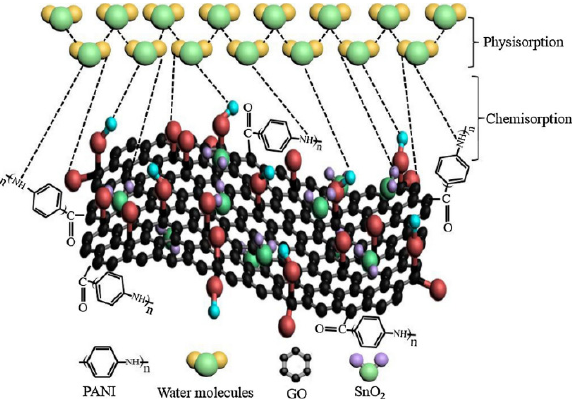
Figure 7. Mechanism of humidity sensing of the GO/SnO 2 /PANI nanocomposite involving phy- sisorption and chemisorption of the water molecules. Reproduced with permission from Zhang et al., Sens. Actuators B Chem.; published by Elsevier, 2018 [28].